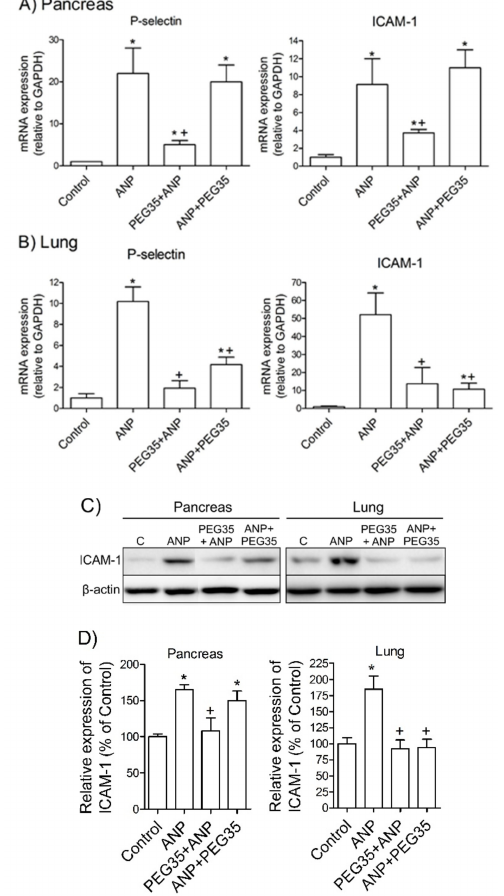
Figure 4. E ff ects of PEG35 administration on the expression of adhesion molecules in acute necrotizing pancreatitis and associated acute lung injury. ( A ) Pancreatic tissue gene expression of P-selectin and ICAM-1 by real-time qRT-PCR. ( B ) Lung tissue gene expression of P-selectin and ICAM-1 by real-time qRT-PCR. In all cases, mRNA induction levels were normalized to GAPDH mRNA expression. ( C ) Pancreatic and pulmonar protein expression of ICAM-1 assessed by Western Blot analysis. B-actin expression was used as loading control. Data shown are representative blots for each group. ( D ) ensitometry quantification of Western blot for ICAM-1 in pancreatic and lung tissue. Bars represent mean values of each group ± SEM. * p < 0.05 versus Control, + p < 0.05 versus ANP. C, Control. ANP, Acute Necrotizing Pancreatitis. PEG35, Polyethylene glycol 35. Each determination was carried out in